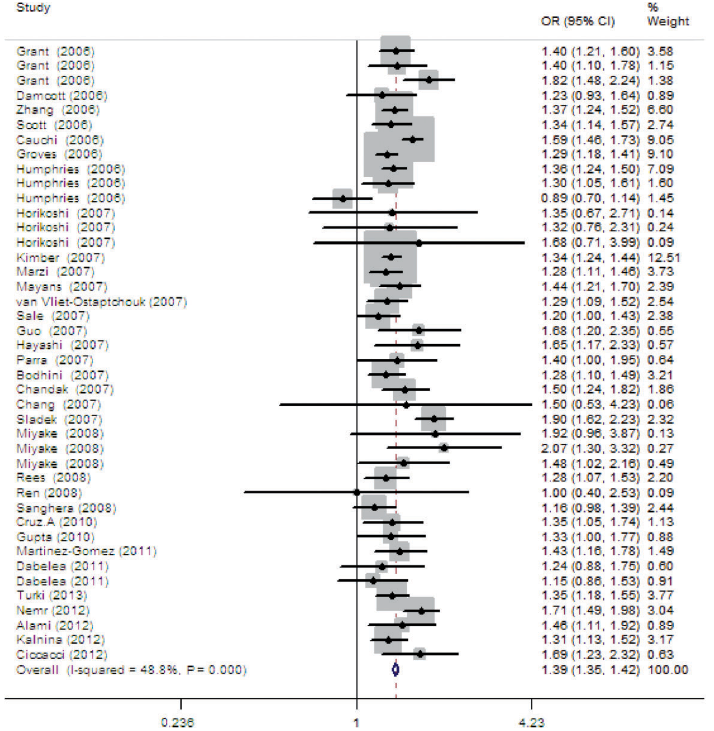
Figure 1. Meta-analysis of the associa- tion between type 2 diabetes and the risk allele T of